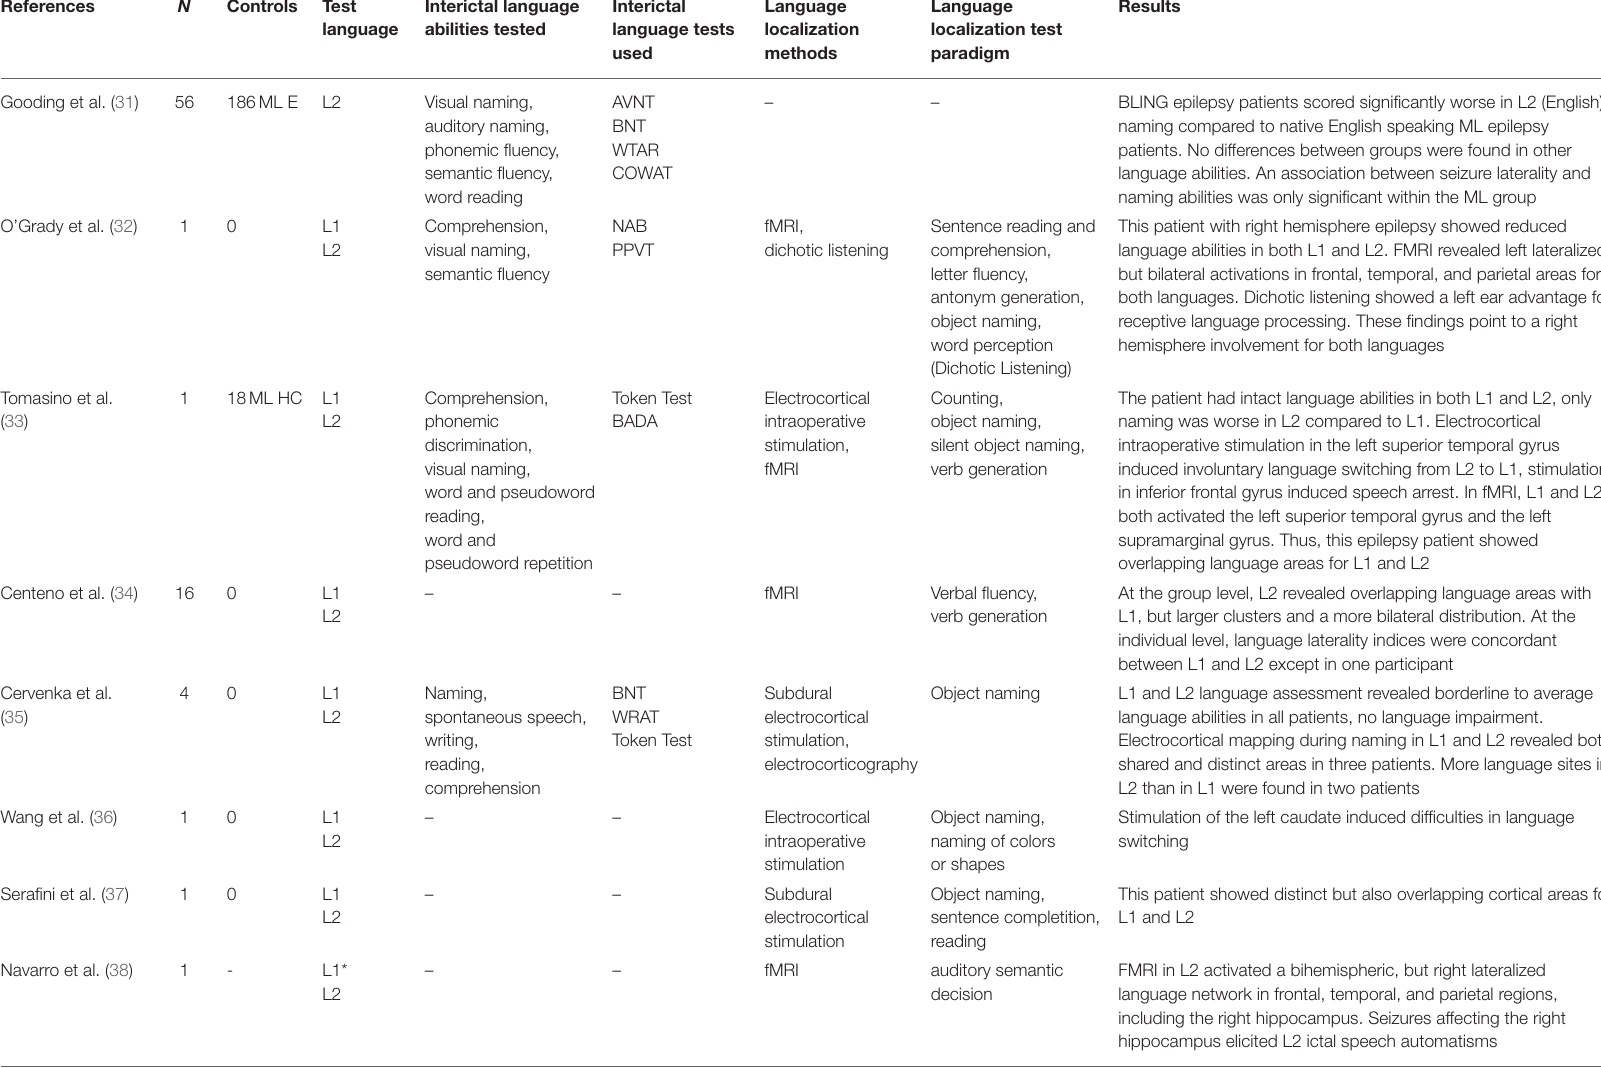
TABLE 2 | Interictal language abilities and/or language localization in bilingual epilepsy